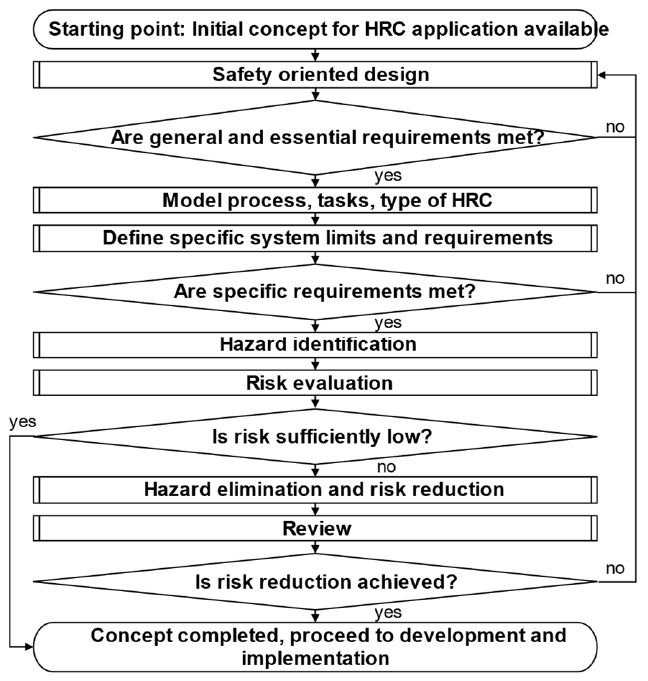
Figure 2. The workflow for ensuring safety of an HRC application, for hazard identification, risk evaluation, risk reduction, and review. Adapted from [19].